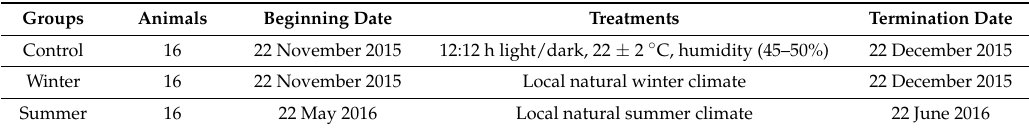
Table 1. Summarization of the animal study procedure for